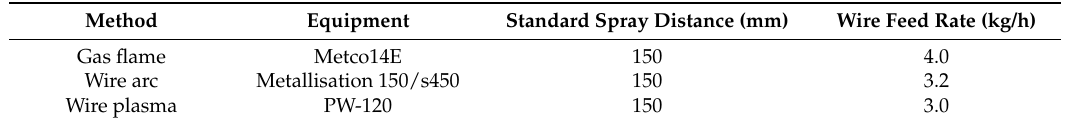
Table 2. Spray parameters used for coating productions.